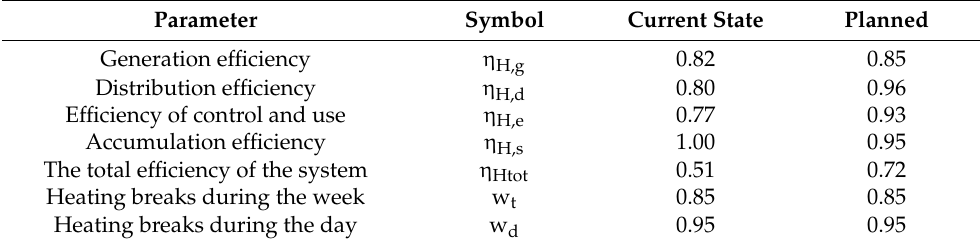
Table 3. The efficiency of the heating system: before and after